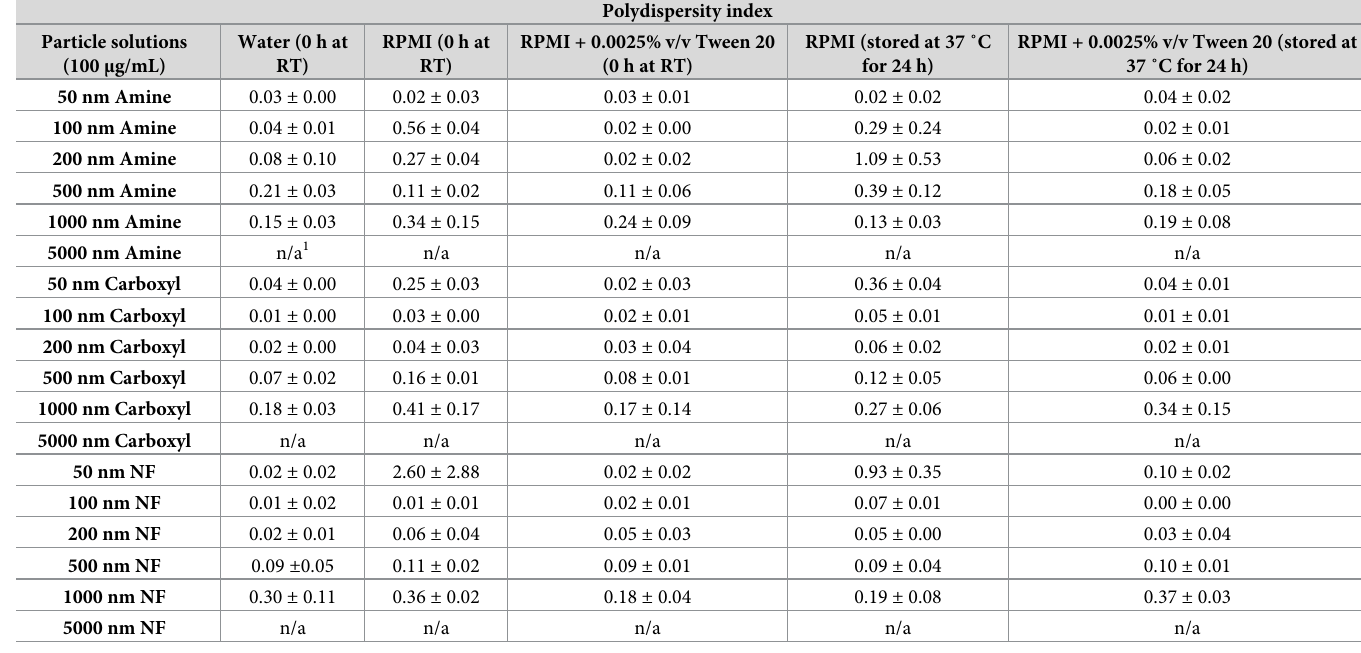
Table 2. Polydispersity indices of polystyrene micro/nanoplastics (mean ± S.D.; n = 3).